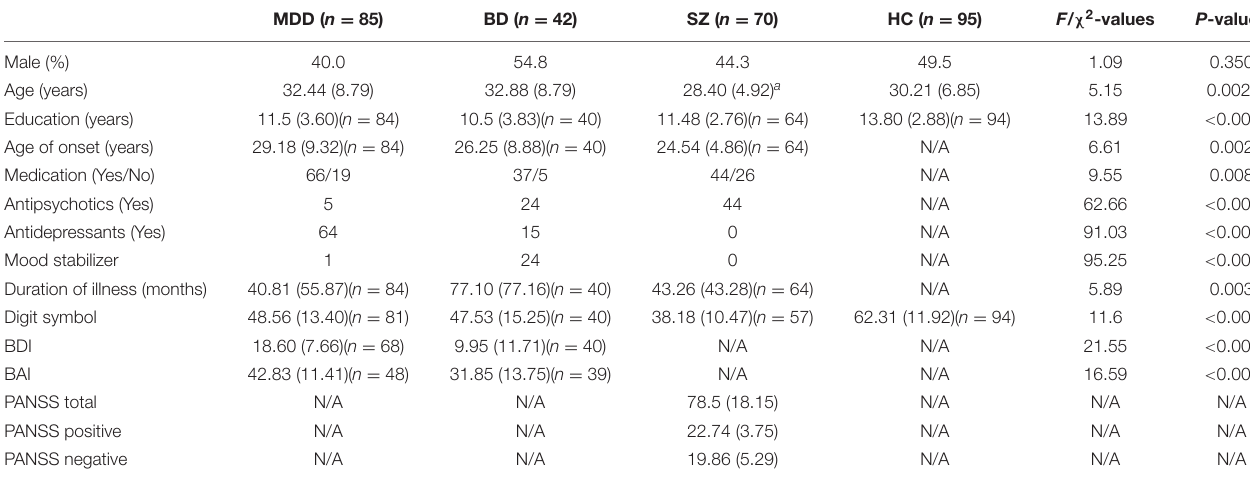
TABLE 1 | Demographic characteristics of the participants.